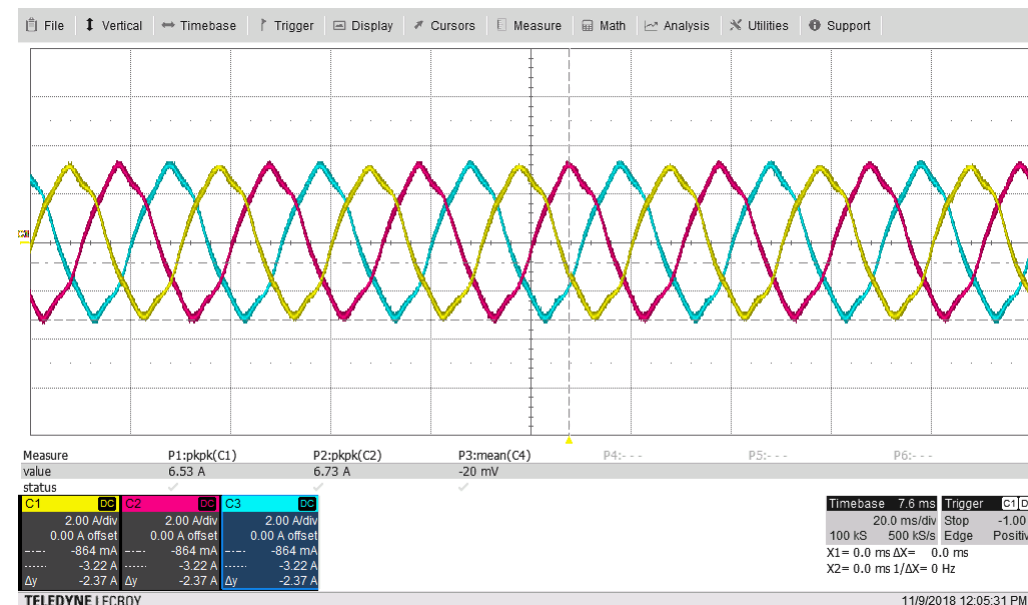
Figure 8. Computational time of the motor control routine.